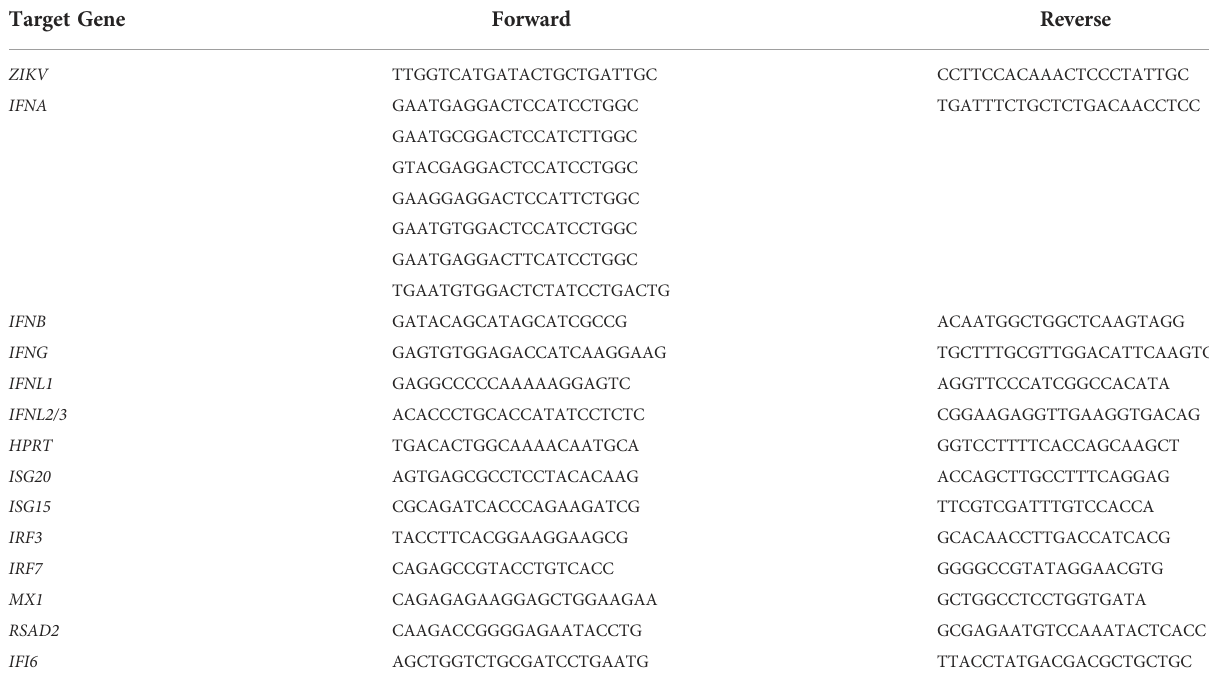
TABLE 1 Primer Sequence for Quantitative